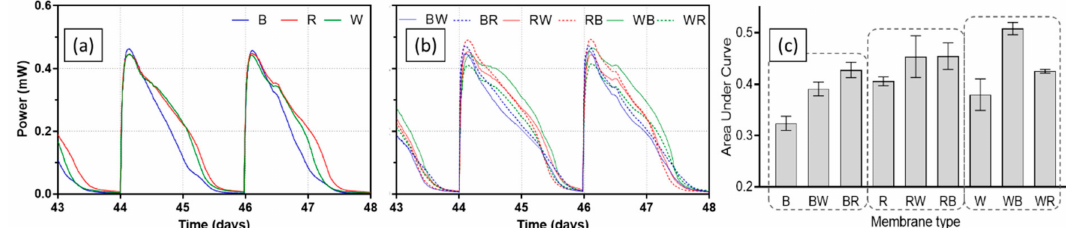
Figure 4. Power outputs of MFCs with test ceramics between day 43 and day 48; single composition ceramics ( a ), spotty ceramics ( b ), and area under curve of each batch feed ( c ). Data represent average values from triplicates of each ceramic type.